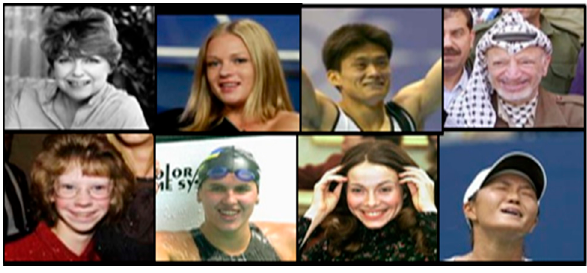
Figure 6. Face images in Labeled Faces in the Wild (LFW) dataset.